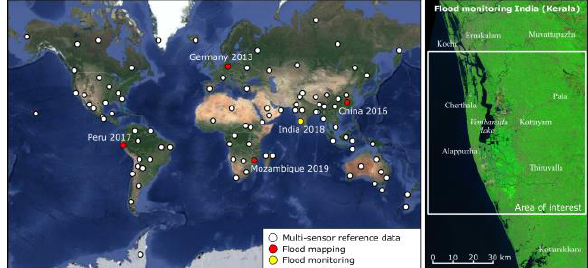
Figure 1. Spatial distribution of reference data, flood mapping tests and flood monitoring application.